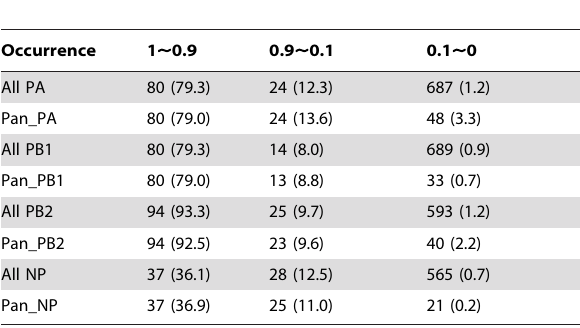
Table 1. A Comparison of the SLiM distributions of RNPs from highly virulent/pandemic (Pan) IAVs and RNPs from all IAVs. Numbers in the brackets beside the raw frequency are average numbers of SLiMs per